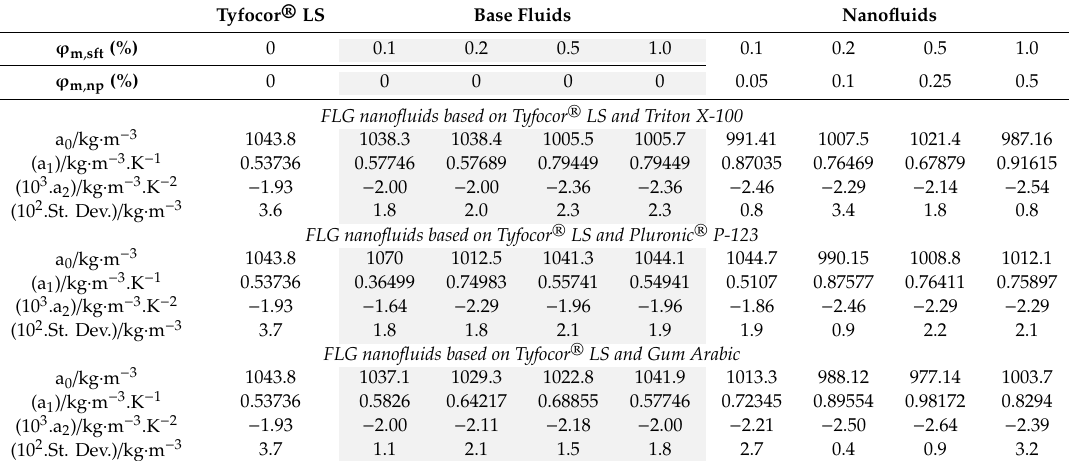
Table 3. Fitting parameters a i and standard deviations (St. Dev.) from Equation (1) for the base fluids and nanofluids with Triton X-100, Pluronic ® P-123, and Gum Arabic as surfactant for di ff erent mass